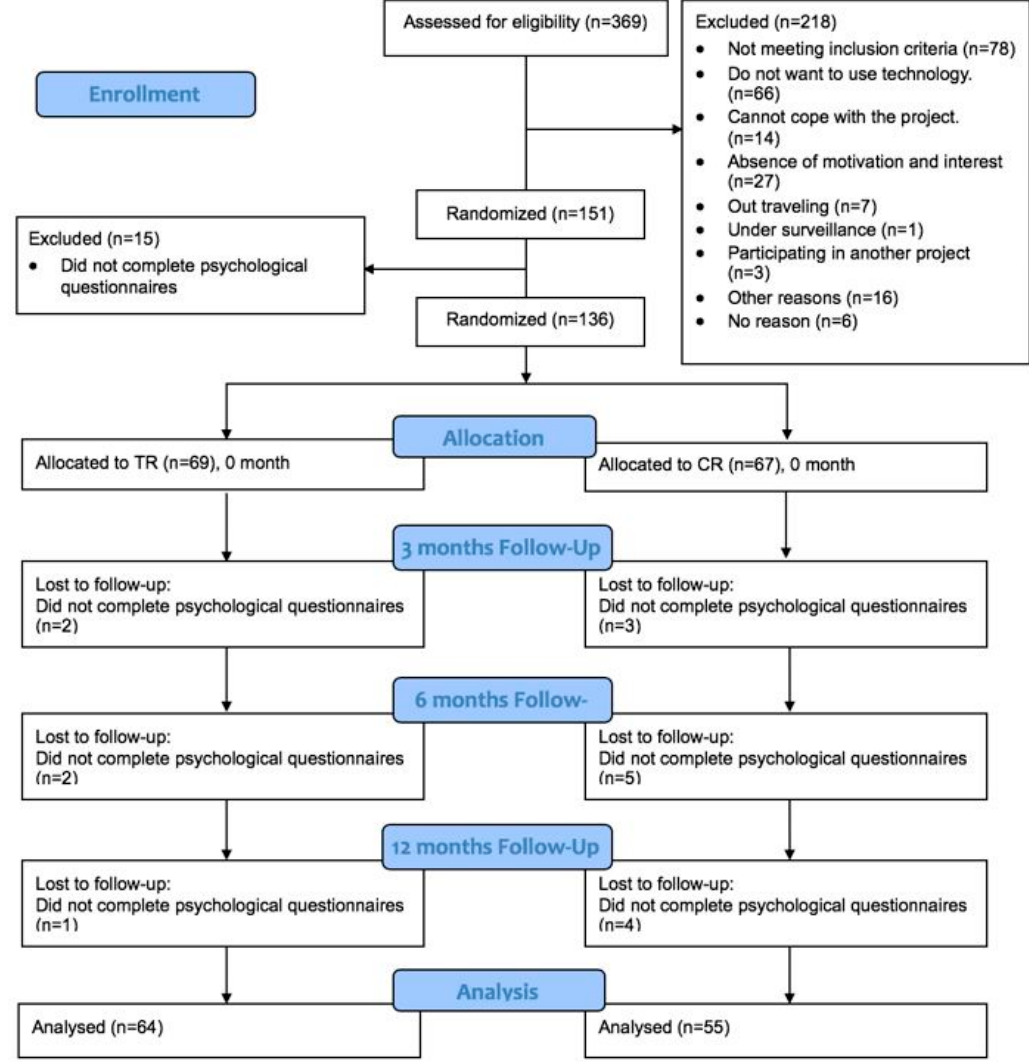
Figure 1. Consort diagram in the Teledialog telerehabilitation program.